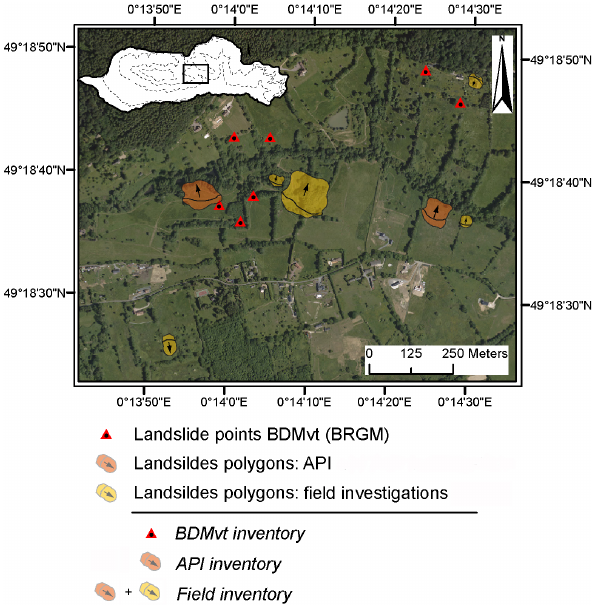
Fig. 5. Example of the different landslide inventories obtained from various sources of investigation. (Note: all landslides mapped by air photo interpretation were confirmed during the field